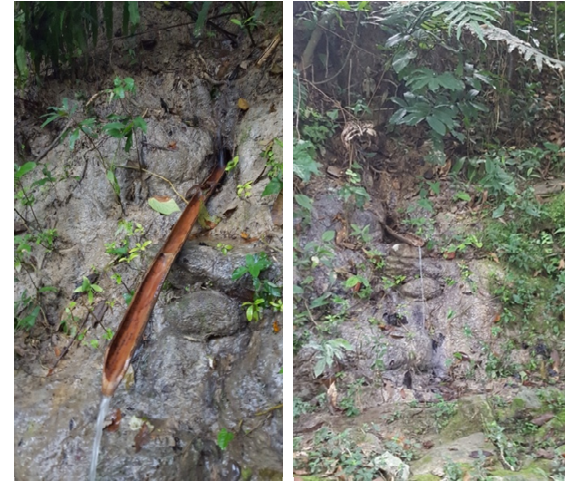
Figure 4. Sampling Point 6 runoff water.